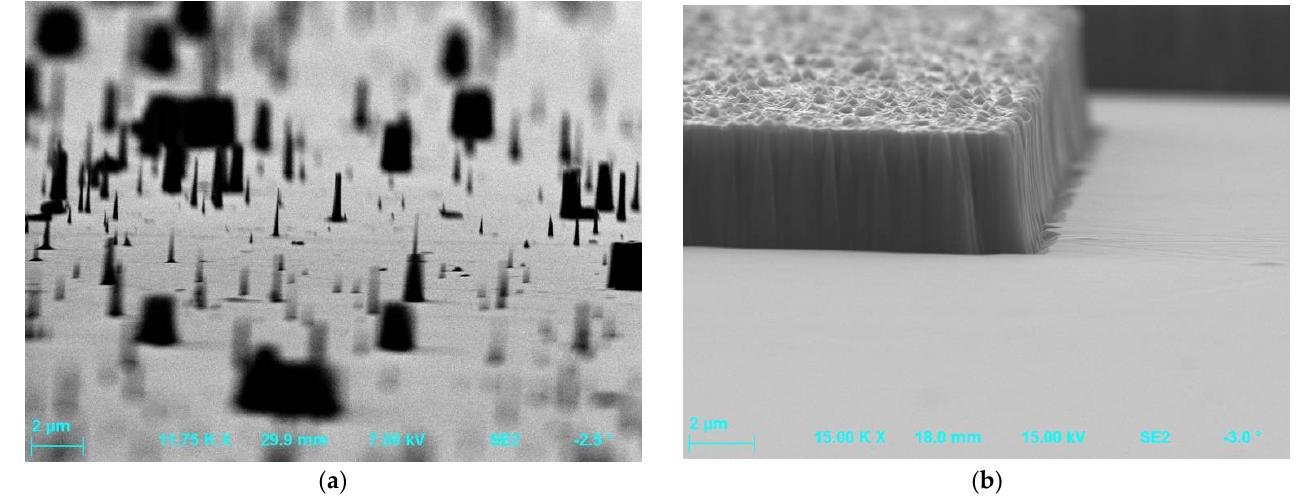
Figure 7. The micromasking effect observed in SiC etching processes: ( a ) with the use of the AZ 4562 resist and parameters: O 2 flow rate = 2 sccm, SF 6 flow rate = 20 sccm, P RIE = 100 W, P ICP = 2000 W, p = 7 mTorr, t = 1 min.; and ( b ) as the result of erosion of the aluminium mask (O 2 flow rate = 2 sccm, SF 6 flow rate = 20 sccm, P RIE = 100 W, P ICP = 900 W, p = 7 mTorr, t = 20 min.).